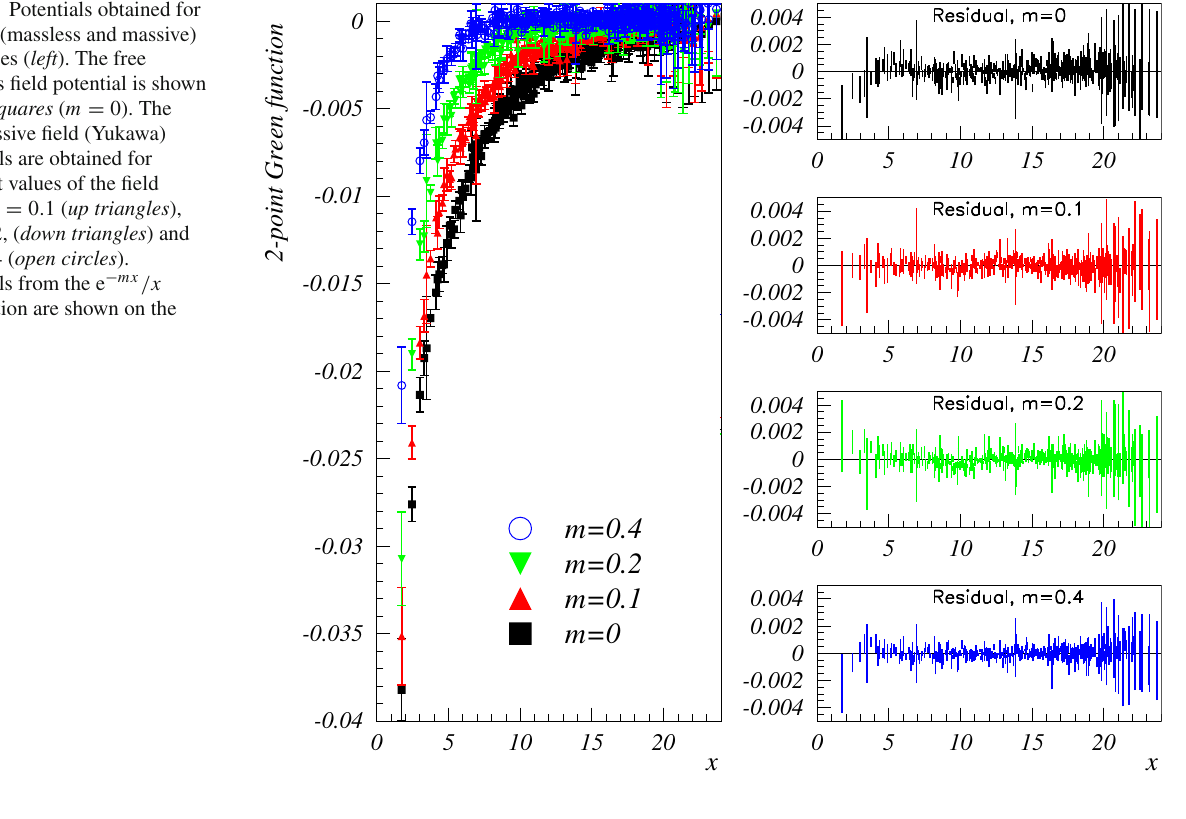
Fig. 11 Potentials obtained for the free (massless and massive) field cases ( left ). The free massless field potential is shown by the sq u ares ( m = 0). The free massive field (Yukawa) potentials are obtained for different values of the field mass, m = 0 . 1 ( u p triangles ), m = 0 . 2, ( down triangles ) and m = 0 . 4 ( open circles